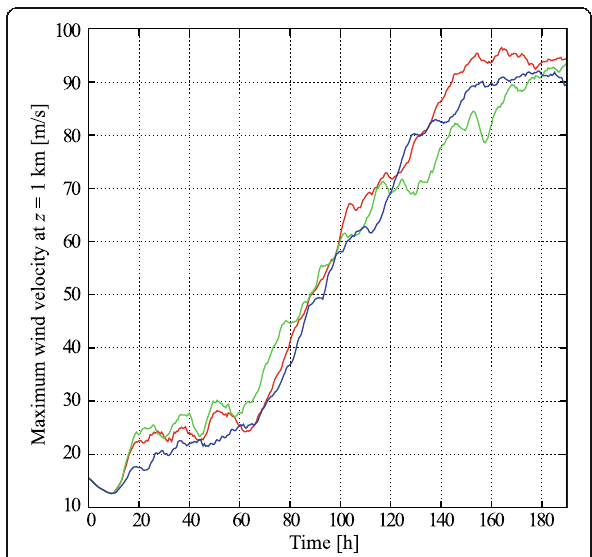
Fig. 6 Temporal evolution of maximum wind velocity at z = 1 km as 150 min (min) moving averaged value with N 0 = 10 cm − 3 (green), − 3 (red), and N − 3 N 0 = 100 cm 0 = 1000 cm